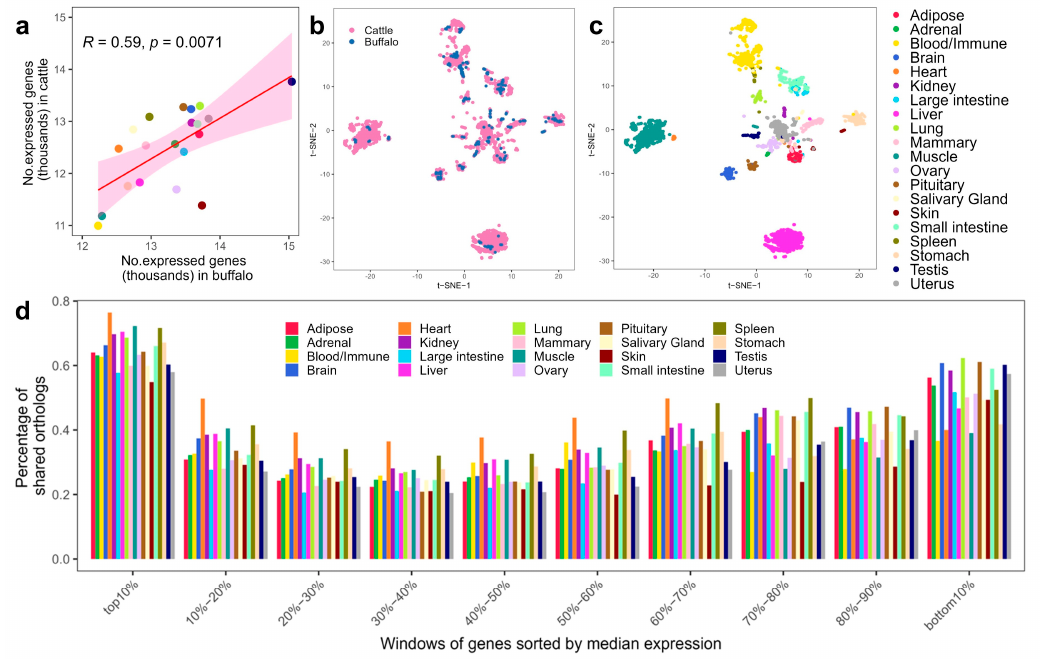
Figure 2. Conservation of transcriptomes of 20 common tissues in buffalo and cattle. ( a ) Spearman’s correlation of a number of expressed genes (median TPM > 0.1) across tissues between buffalo and cattle. Each dot represents a tissue. ( b ) The plot of t-SNE of samples based on batch-corrected gene expression (Methods). Each dot represents a sample colored by species types. ( c ) Same as in ( b ) but colored by tissue types. ( d ) Percentage of orthologous genes shared in each window between buffalo and cattle. Genes were ranked (from largest to smallest) by median expression in each tissue of each species and then divided into ten windows evenly.